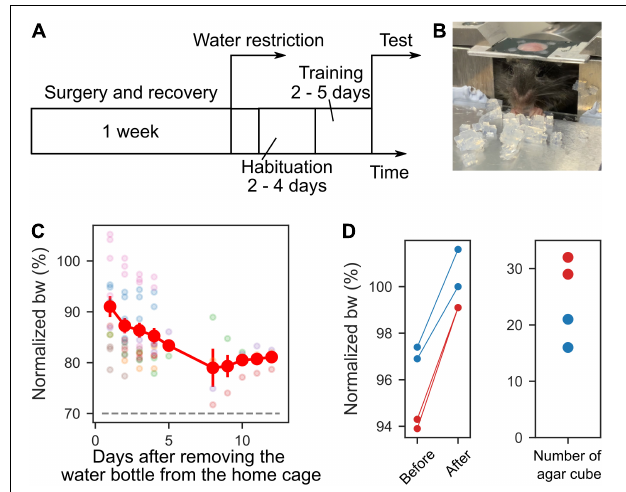
FIGURE 2 | Time course of experiment and body weights. (A) Time course of the experiment. One week after the recovery period from the surgery, water restriction was started. Before the test session, habituation and training periods were scheduled. (B) Photograph of a mouse during the training. (C) Mice body weights (bw) during habituation, training, and test sessions. The body weights were normalized to that on the day water restriction was started. The dashed gray line indicates 70%. Each color represents a different mouse ( n = 7). (D) Left, the normalized weights of four sessions from two mice before they ate the agar cubes and after they could no longer eat them. Right, the number of agar cubes eaten by the